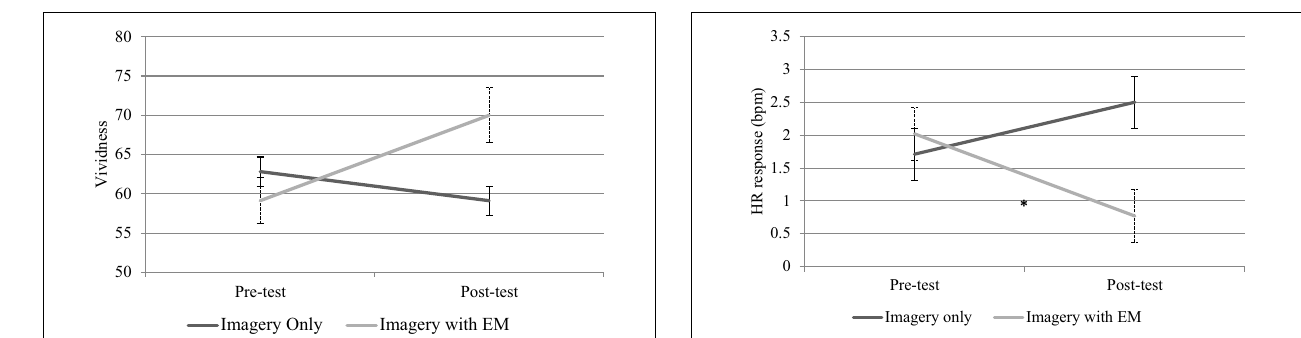
FIGURE 2 | Mean vividness ratings with standard error bars for imagery only ( n === 17) and imagery with eye movements (EM; n === 17) conditions .